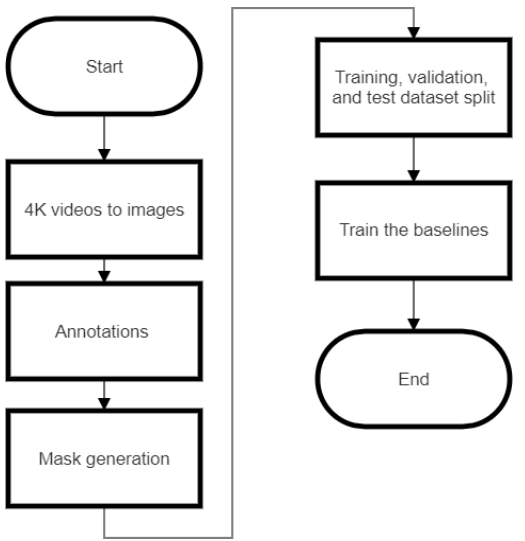
Figure 10. The overall workflow for the prediction of ash tree decline and